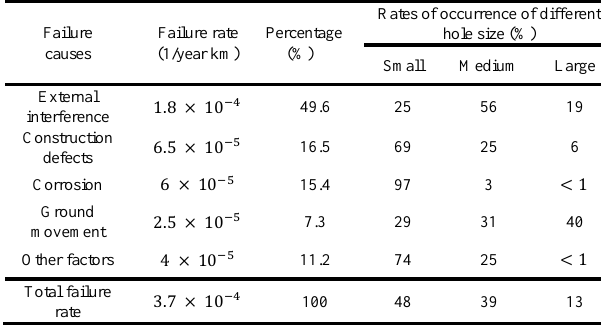
Table 1. Examples of different causes of failure and the corresponding rates of failure types (EGIG